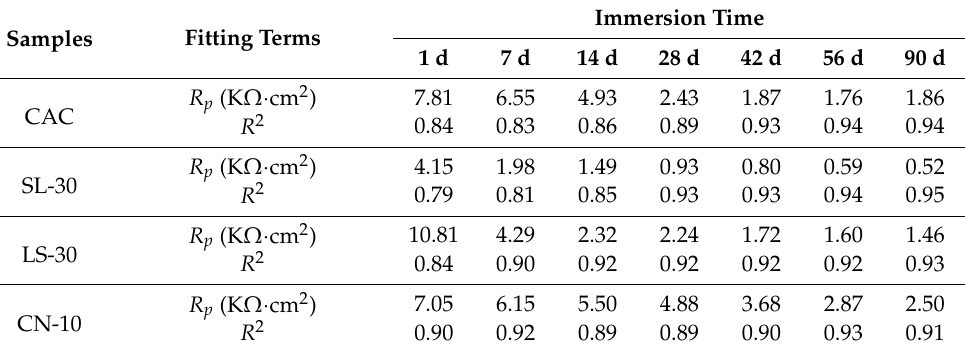
Table 7. Mix proportion of the pastes used for the mortar-reinforcement specimens (wt.%).